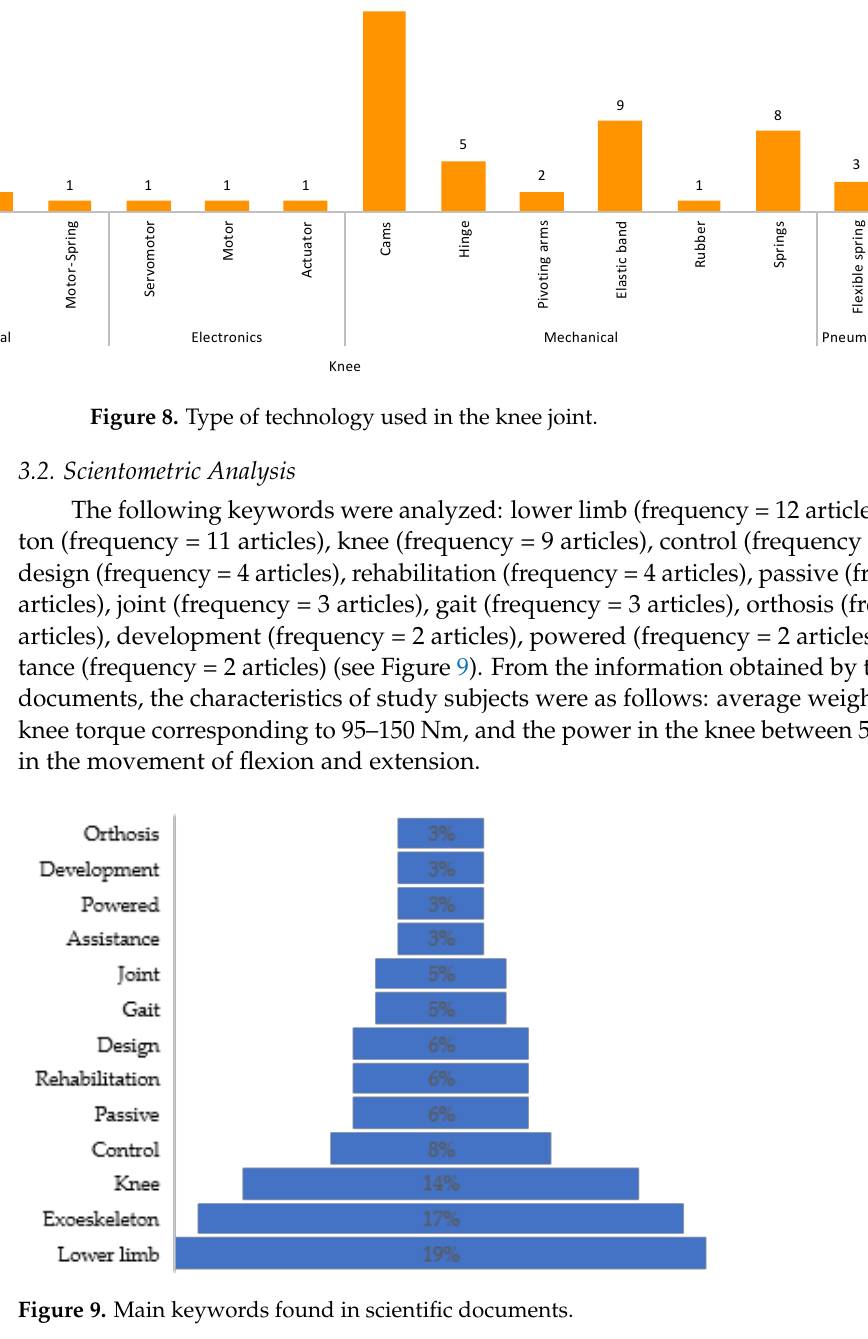
Table 4. Top authors’ production over time.